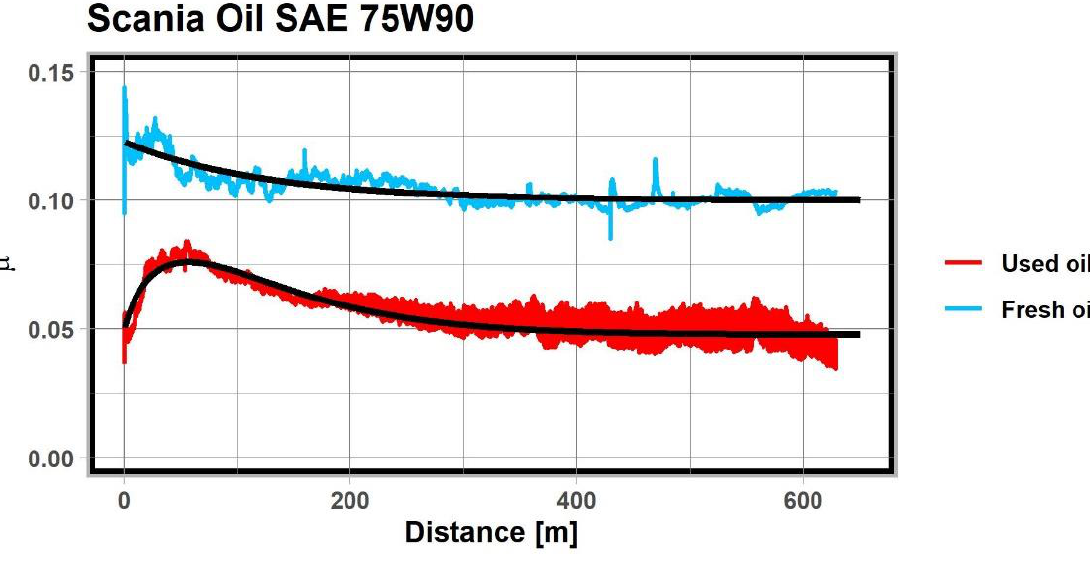
Figure 6. The curve of the friction coefficient depending on the friction path for oil SAE 75W-90 and fitting Function (1).